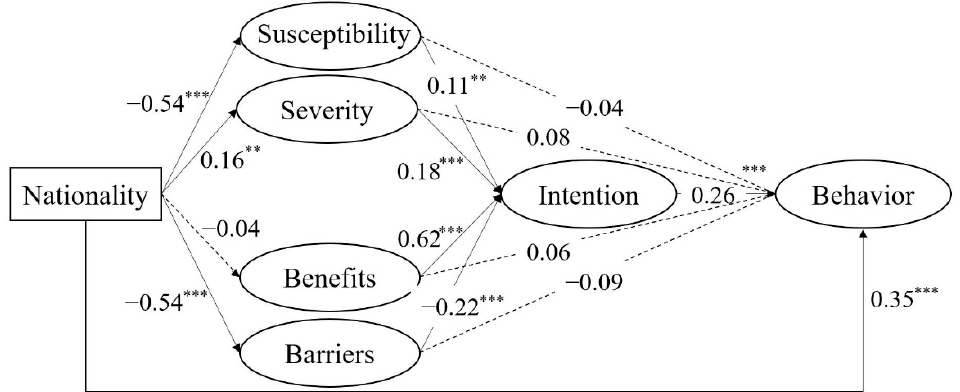
Figure 3. The model of health beliefs and behavioral intention between nationality and engaging in stay-at-home behaviors. Note. The solid/dotted lines indicate significance/non-significance. All coefficient estimates are completely standardized. Nationality (0 = USA, 1 = China). * p < 0.05, ** p < 0.01, *** p < 0.001.